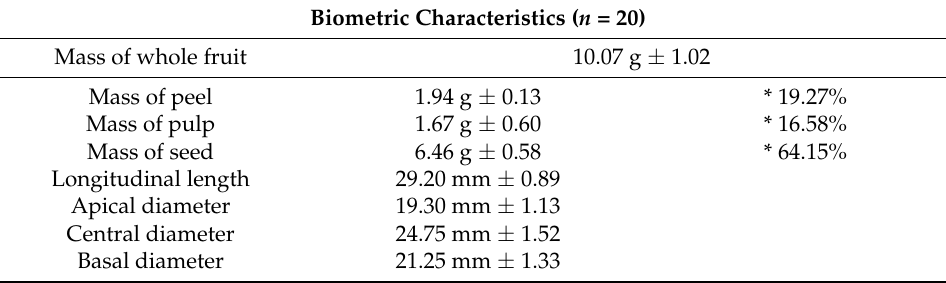
Table 1. Biometric characteristics of the buritirana fruit and its